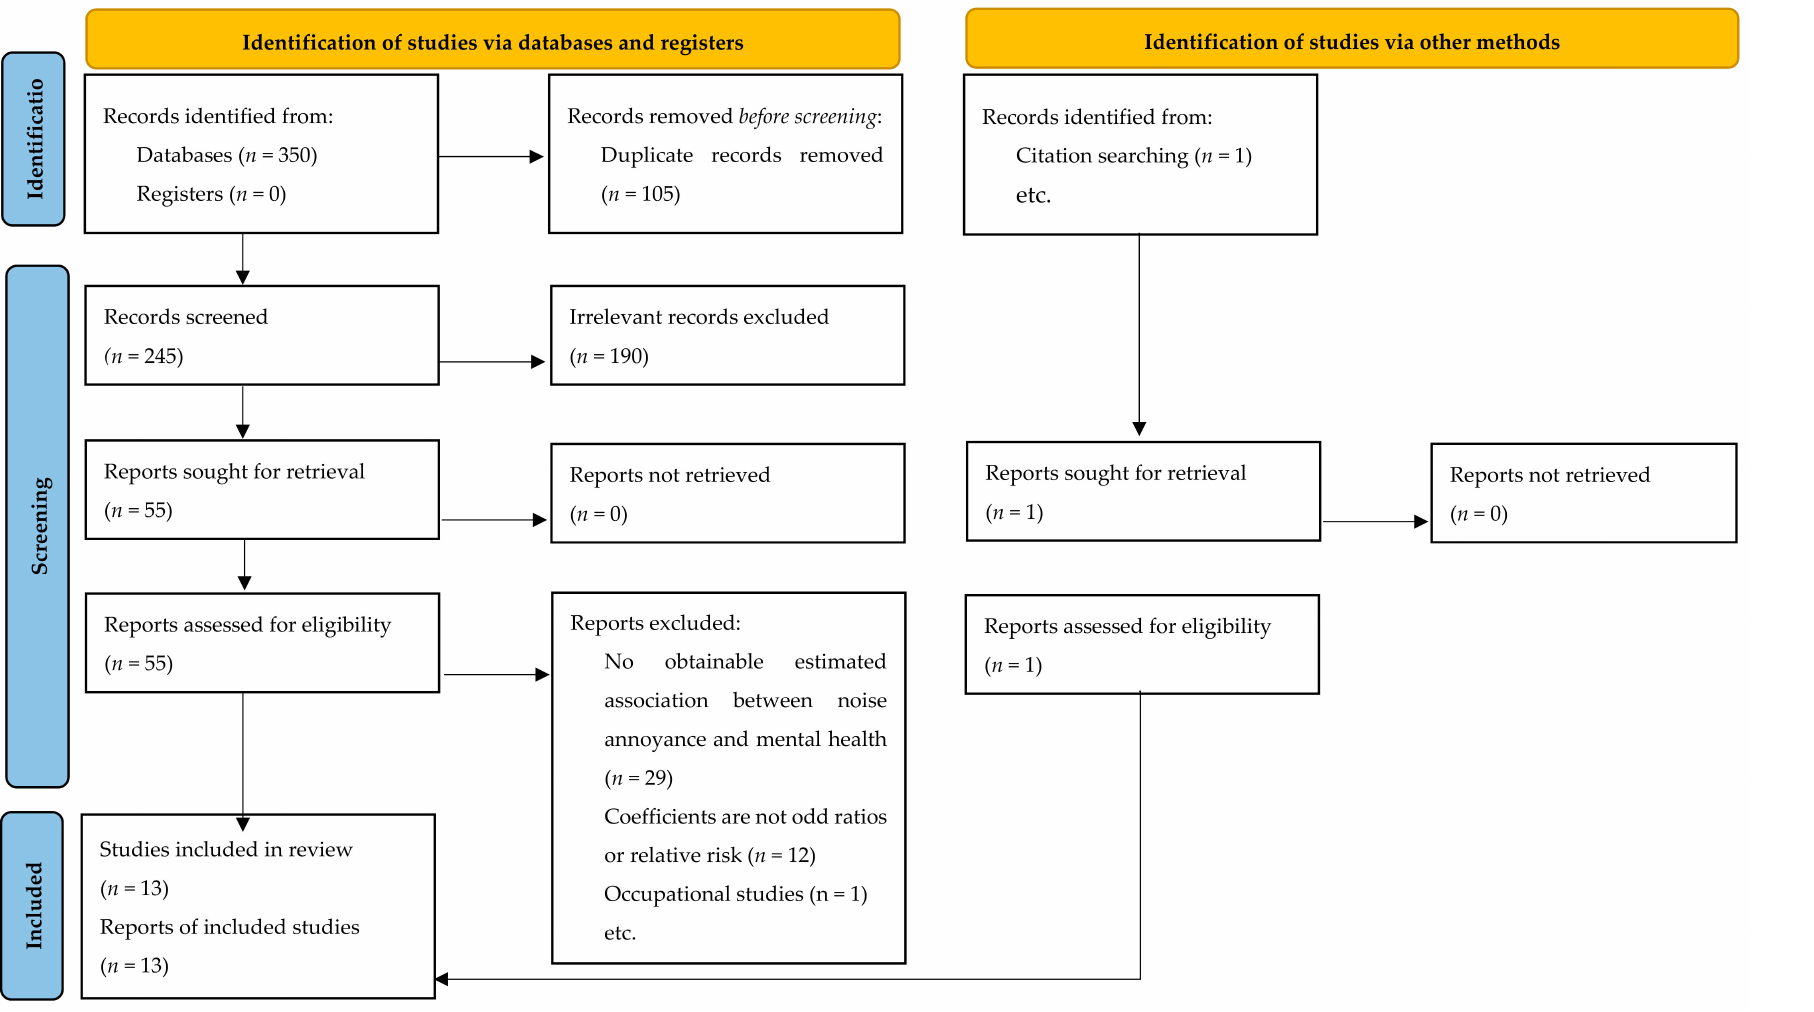
Figure 1. PRISMA flow chart showing number of papers identified